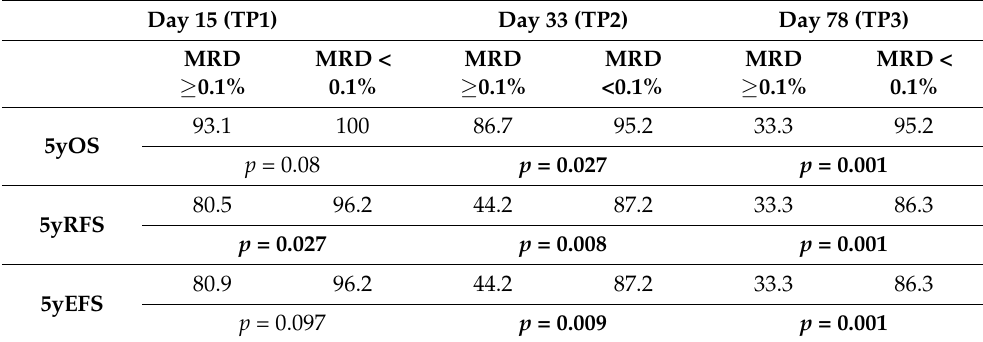
Table 6. Outcomes by MRD result: MRD ≥ 0.1% vs. MRD < 0.1% on day 15 (TP1), 33 (TP2) and 78 (TP3). Day 15 (TP1)